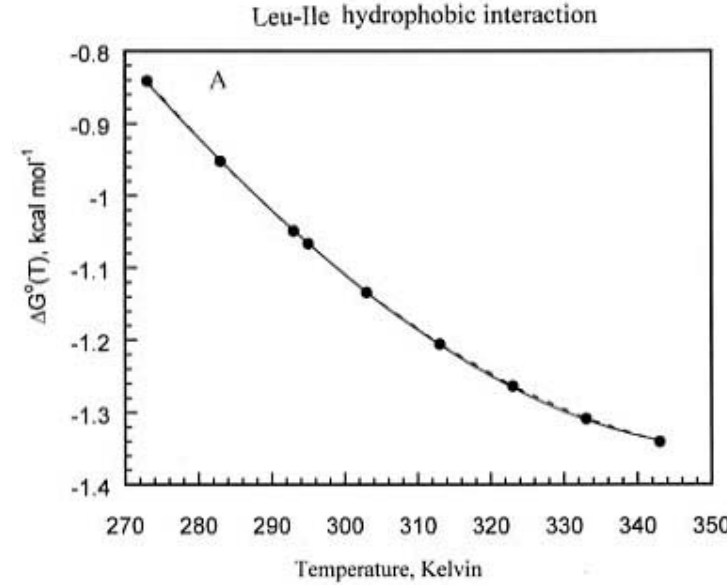
FIGURE 2A . Thermodynamic plot of the standard Gibbs free energy change of Leu-Ile hydrophobic interaction. Values for ∆ G o (T) as a function of temperature were computed from Nemethy and Scheraga’s Table II[8] in the temperature range 273–333 K, using the general linear model (T 3 model) procedure of statistical analysis of IMSL subroutine. The solid line represents fitted data. F = 0.0001, thus the goodness of fit of the experimental data was 99.9% or better in each case[31,32].